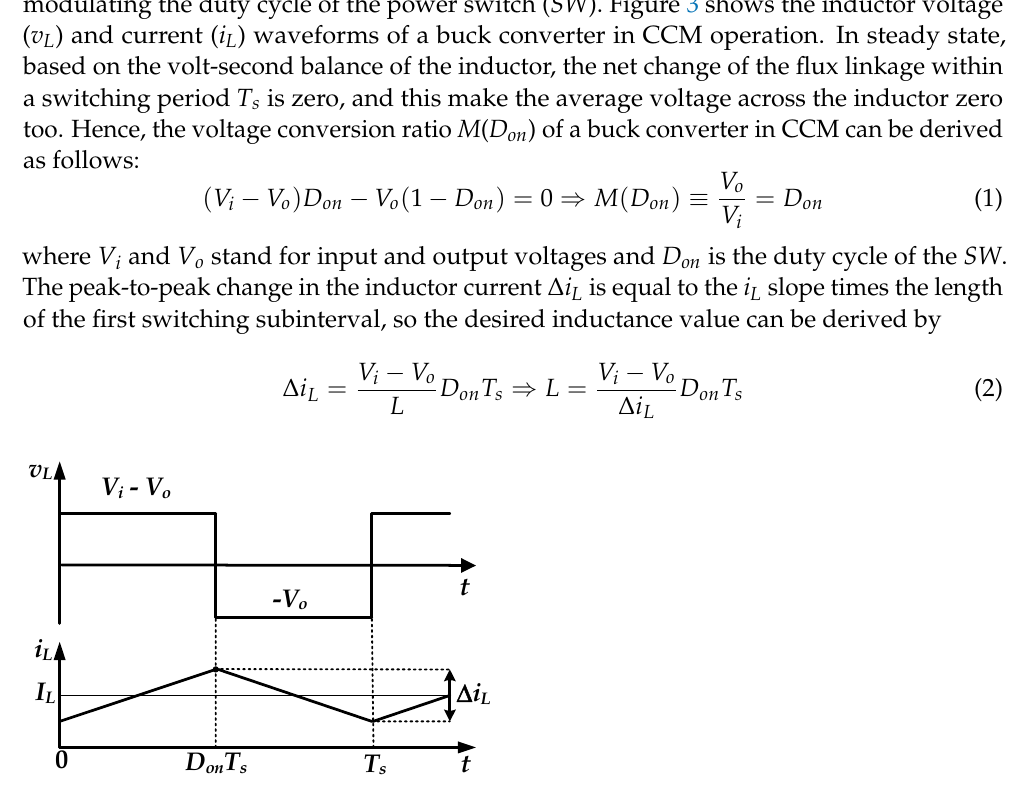
Figure 3. Waveforms of inductor voltage ( v L ) and current ( i L ) in CCM. The charge change ( ∆ q ) in the output filter capacitor ( C ) is related to the capacitance value and the peak-to-peak output voltage ripple ∆ V o , which can be expressed as ∆ q = C